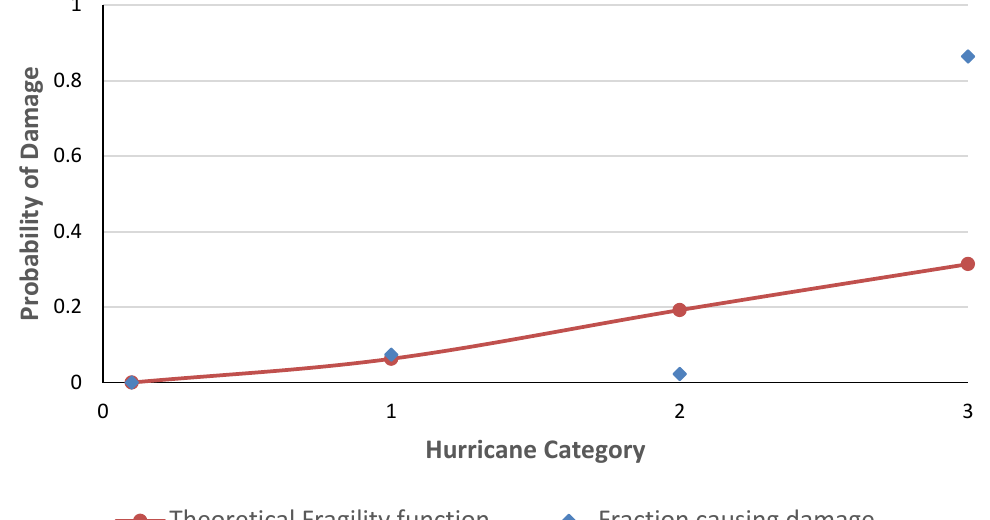
Figure 5. Fragility curve for signs and signals damaged based on hurricane categories in Florida. NB: signs and signals include signs (horizontal and vertical members), traffic signals, small signs, lights and fixtures and roadway and bridge operation facilities.